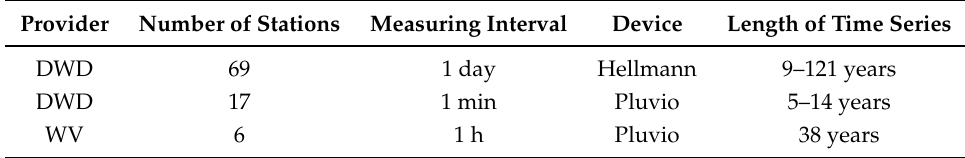
Figure 1. Study area containing 92 gauge stations with different measurement periods. The black line borders the Wupper catchment. Gauges marked white are those used as example stations (Schwelm (square) and Solingen-Hohenscheid (diamond)). The altitude is coded along a grey scale and stems from http://www.diva-gis.org/gdata, river shapes come from https://www.openstreetmap.org. Table 1. Properties of precipitation gauge